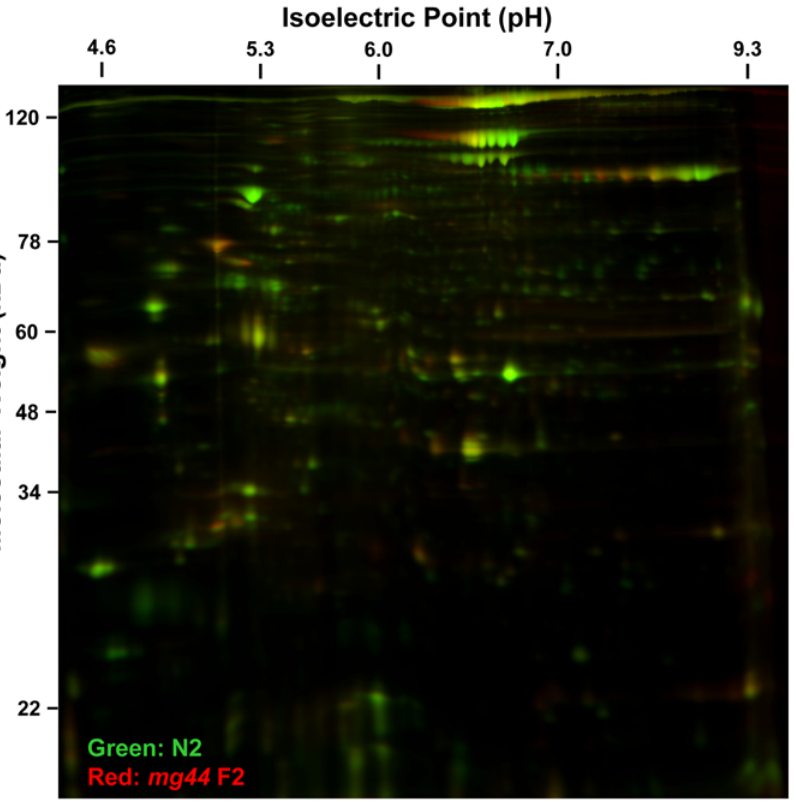
Figure 2. Most phosphoproteins are depleted in age-1(mg44) F2 adult worms. A 2-dimensional polyacrylamide gel electrophoresis resolves dual-labeled phosphoproteins, enriched on phospho-affinity columns (Qiagen), from age-1(mg44) F2 worms collected 10 d after the L4/adult molt (red fluorescence) and from post-gravid, near-isogenic N2DRM controls 6 d after becoming adults (green fluorescence). A total of 1,669 spots were identified and quantified for each fluor after co-electrophoresis. Red/green ratios equal to or greater than 2 ( i.e. , at least 2-fold more abundant in age- 1(mg44) than in N2DRM adults) were observed for 13 spots; 30 had ratios of 1.2–2.0; 122 were essentially constant (ratios of 0.8–1.2); 305 fell between 0.5 and 0.8; and 1,199 were reduced at least twofold in abundance in age-1(mg44) adults. A reduction of at least 3-fold was seen for 784 spots, and $ 5-fold for 287 spots.